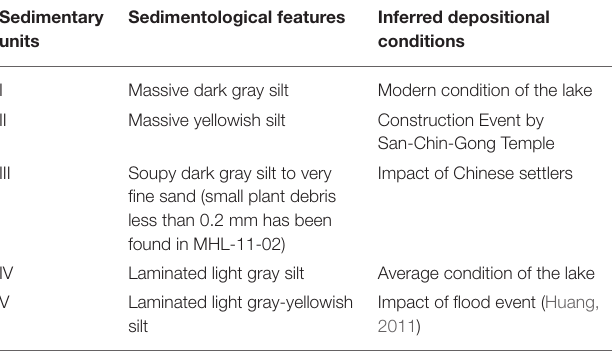
TABLE 1 | Sedimentary units, its characteristic features and inferred depositional conditions of the Lake Meihua sedimentary sequence in core MHL-09-01 and